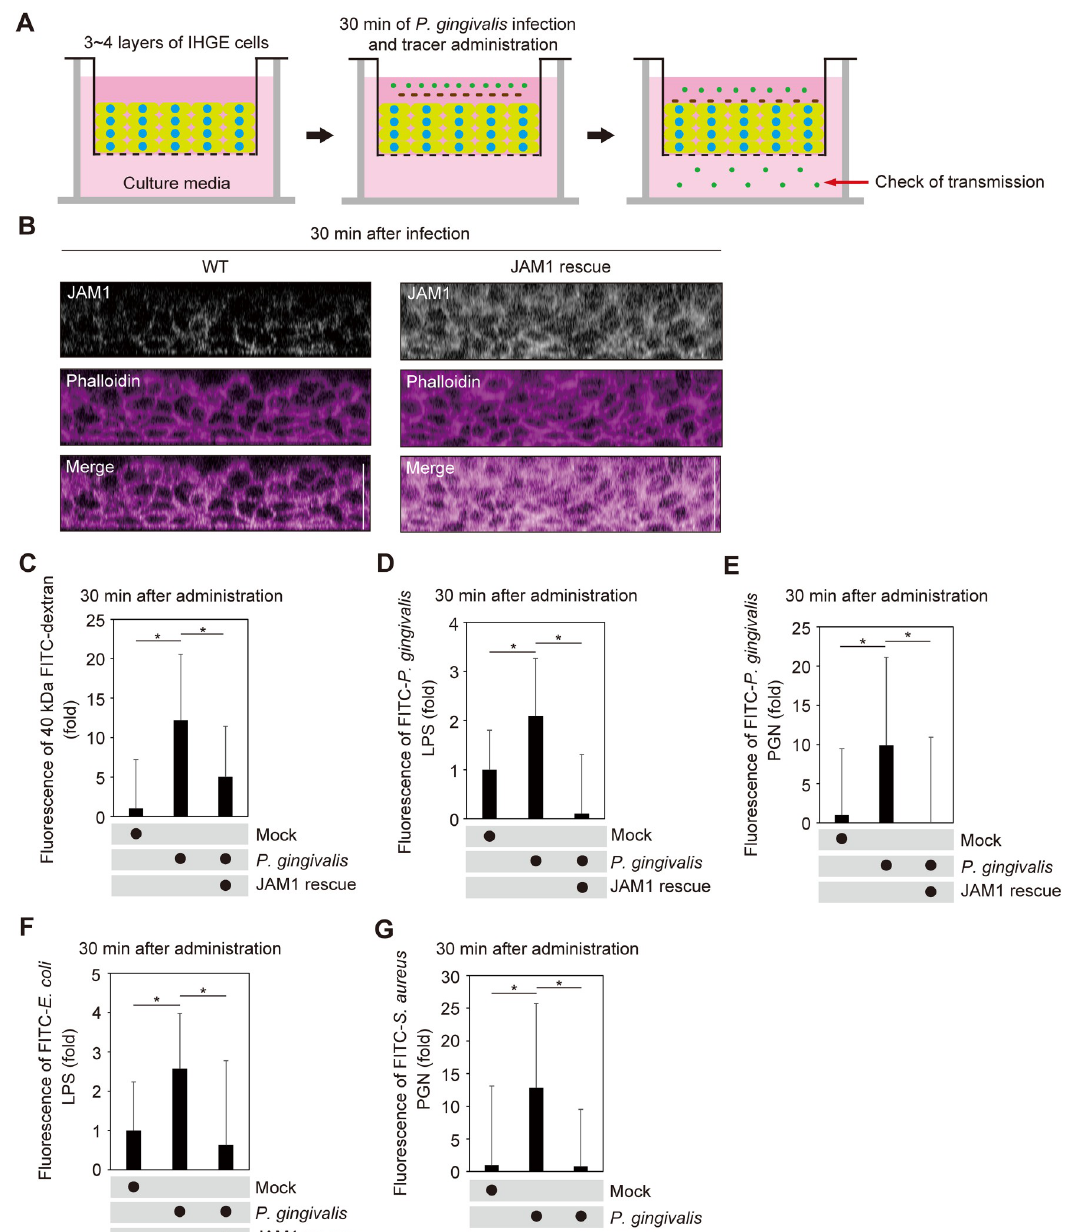
Fig 9. P . gingivalis degrades JAM1 of gingival epithelium, causing penetration of LPS and PGN. (A, B) Schematic illustration of the three-dimensional culture (A) and confocal microscopic cross-sectional images (B) of the three-dimensional culture of IHGE cells. Gingival epithelial tissues (WT or overexpressing JAM1) were infected with P . gingivalis for 30 min. Tissues were then fixed, stained with anti-JAM1 (white) and Alexa Fluor 568–conjugated phalloidin (magenta), and analyzed by confocal microscopy. Scale bars, 30 μ m. (C – G) Permeability to 40 kDa FITC-dextran (C), FITC– P . gingivalis LPS (D), FITC– P . gingivalis PGN (E), FITC– E . coli LPS (F), and FITC– S . aureus PGN (G) of gingival epithelial tissues (WT or overexpressing JAM1) infected with P . gingivalis . Three- dimensional tissues on culture inserts were infected with P . gingivalis and FITC-labeled tracer in the upper compartment. Following 30 min of incubation, the transmission of tracer from the upper compartment to the lower compartment was analyzed by spectrometry. Results are expressed as fold change relative to uninfected WT cells and are the means ± SD of seven technical replicates. � , p < 0.05, one-tailed t test (closed testing procedure).